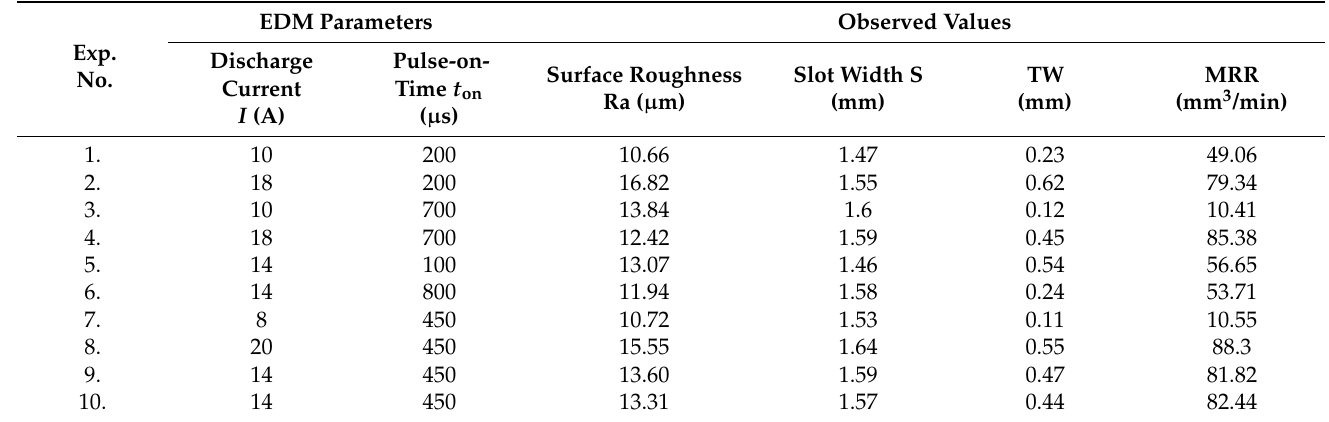
Table 5. Design of the experimental matrix with the results of experimental studies.